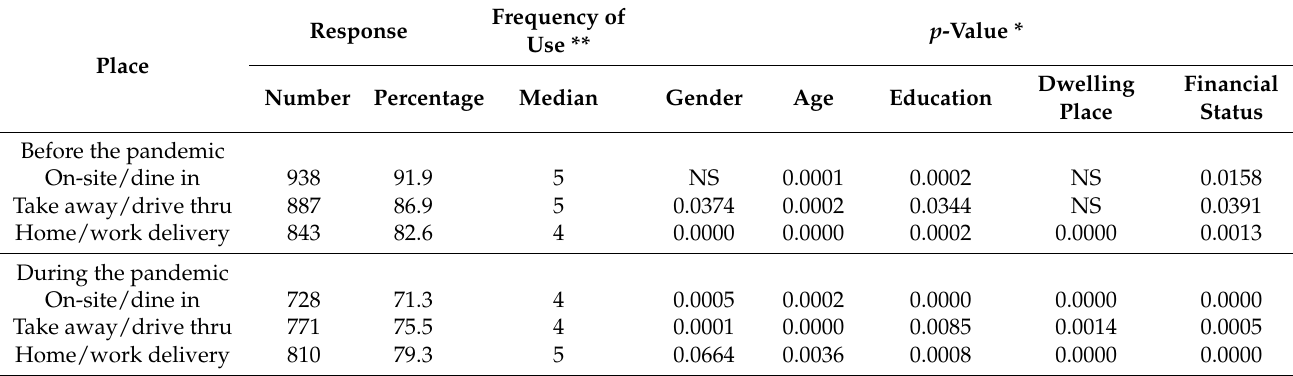
Table 3. Using catering establishments and frequency of use by respondents before and during pandemic.